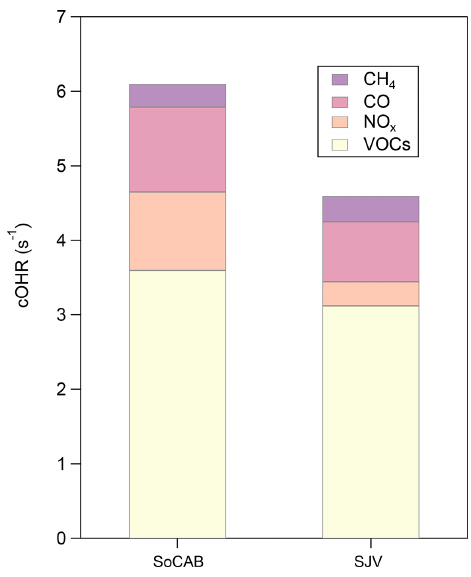
Figure 3. The total measured cOHR for the SoCAB and